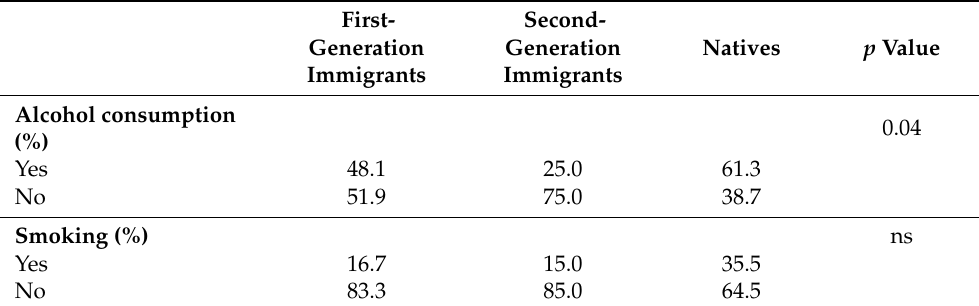
Table 7. Alcohol consumption and smoking habits by migration